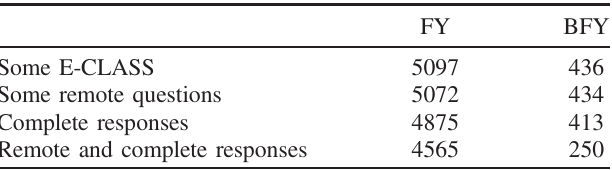
TABLE I. Total number of students who responded to (i) at least one E-CLASS question ( “ some E-CLASS ” ), (ii) at least one of the remote lab survey questions ( “ some remote questions ” ), (iii) all of the remote lab survey questions that we use as inputs and outputs for our regression models ( “ complete responses ” ), and (iv) all of the remote lab survey questions that we use as inputs and outputs for our regression models and who partici- pated in their course entirely remotely. Each of these categories is a subset of the previous ones and the number of students is divided into students in first-year (FY) and beyond-first-year (BFY) courses.